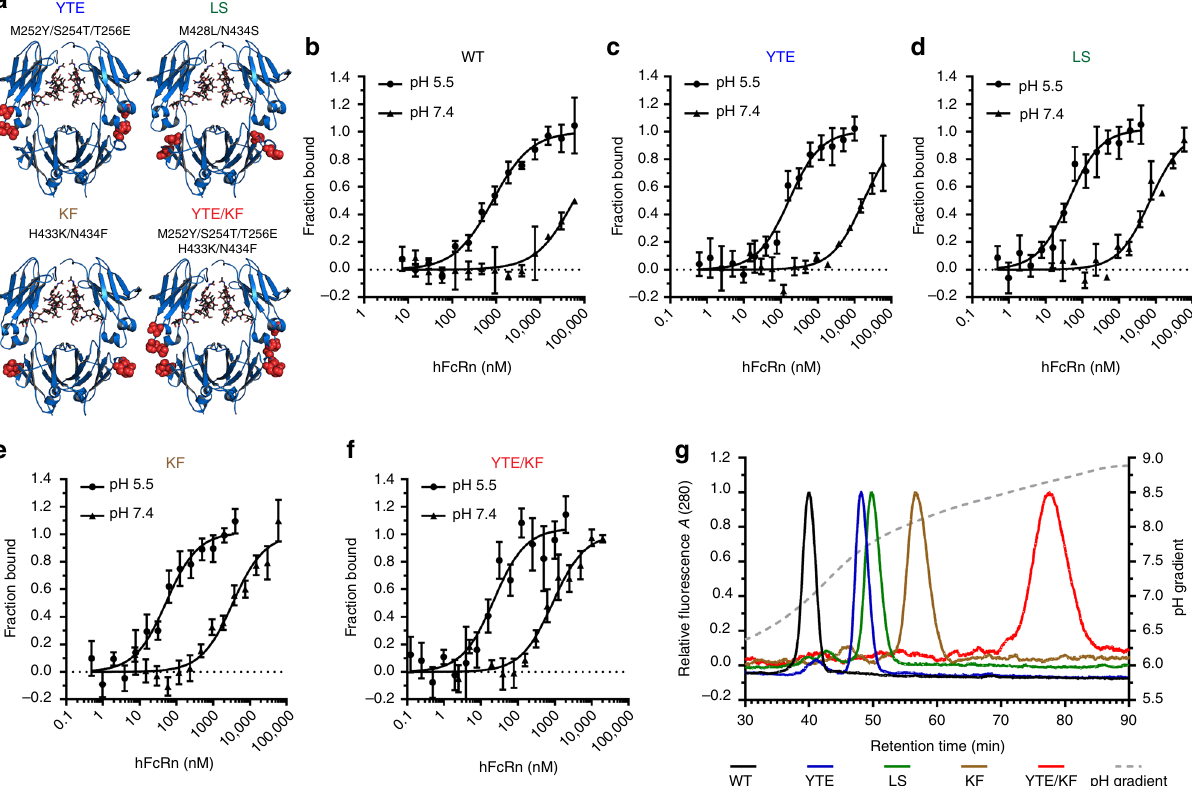
Fig. 4 hFcRn binding characteristics of Fc-engineered IgG variants. a Illustrations of the crystal structure of hIgG1 Fc (blue) with the amino acid residues targeted by mutagenesis highlighted in red spheres: M252Y/S254T/T256E (YTE), M428L/N434S (LS), H433K/N434F (KF) and M252Y/S254T/T256E/ H433K/N434F) (YTE/KF). The fi gure was designed using the PyMOL software with the crystallographic data of hIgG1 Fc 69 . MicroScale